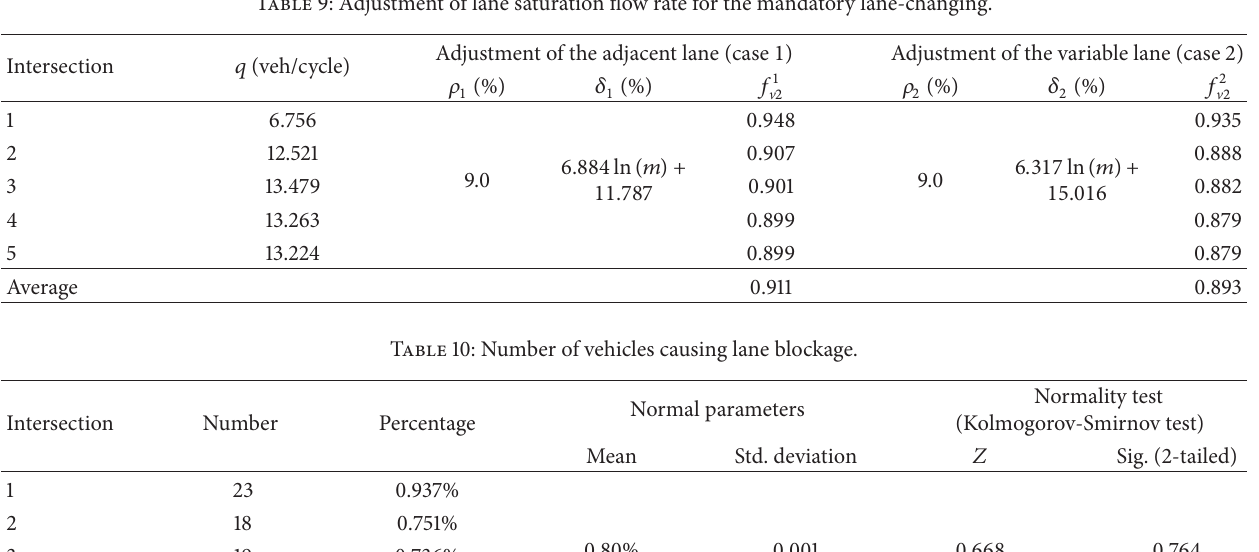
Table 9: Adjustment of lane saturation flow rate for the mandatory lane-changing.